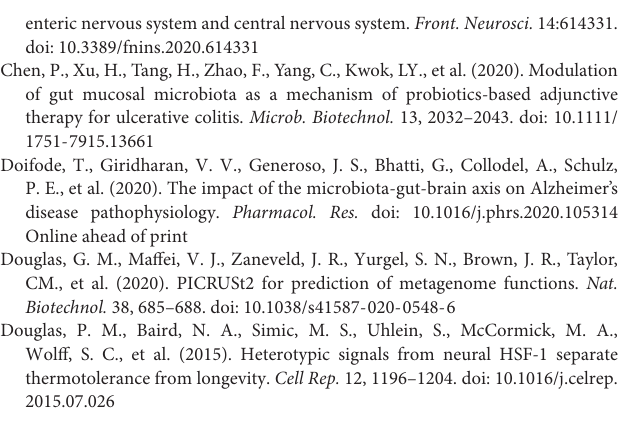
Supplementary Figure 3 | The characteristics in the repeated stress-related diarrhea based on the data integration reanalysis. (A) Body weight; (B) Intestinal propulsion rate; (C) Thymus index; (D) Mean corpuscular hemoglobin concentration; (E) Weight cell count; (F) D-xylose. ∗ p < 0.05, ∗∗ p < 0.01,